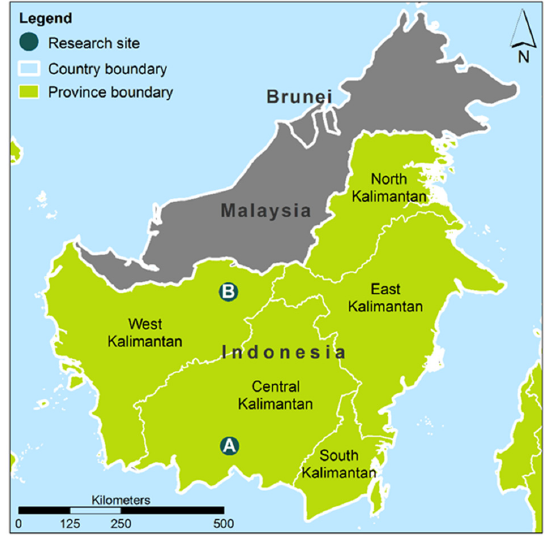
Figure 1. Research sites at the Island of Borneo in the Indonesian part (Kalimantan): ( A ) peat swamp